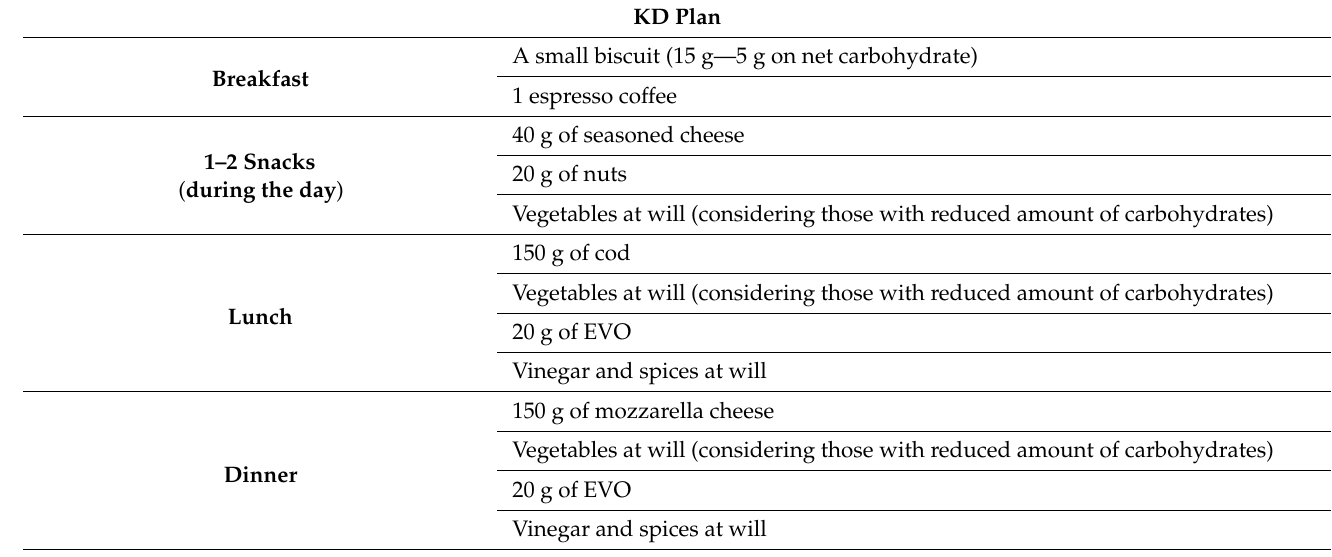
Table 1. Scheme of KD